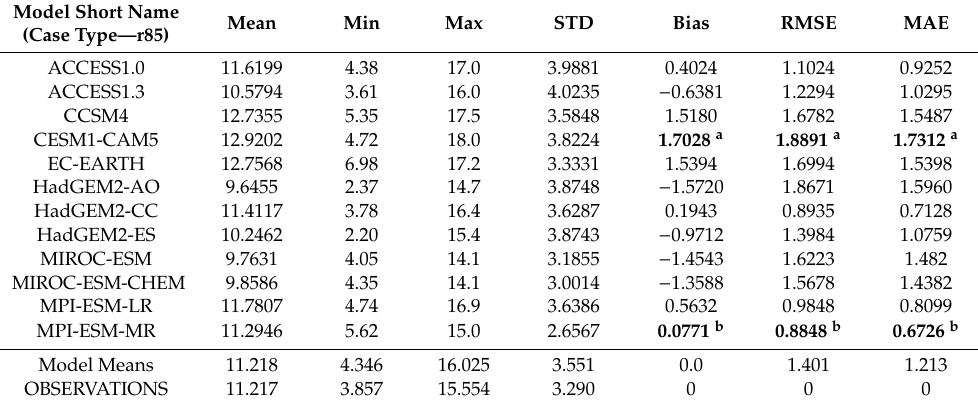
Table 4. Statistics of SIE time series of climate model projections for the scenario RCP8.5 (r85) for 2006–2017. The basic statistics of the observed SIE time series are also included in the last row in bold for reference. Units are 10 6 km 2 . The values in bold under the Bias, RMSE, and MAE columns denote the maximum magnitudes (not absolute values; superscript a) and the minimum magnitudes (superscript b) amongst all values in the